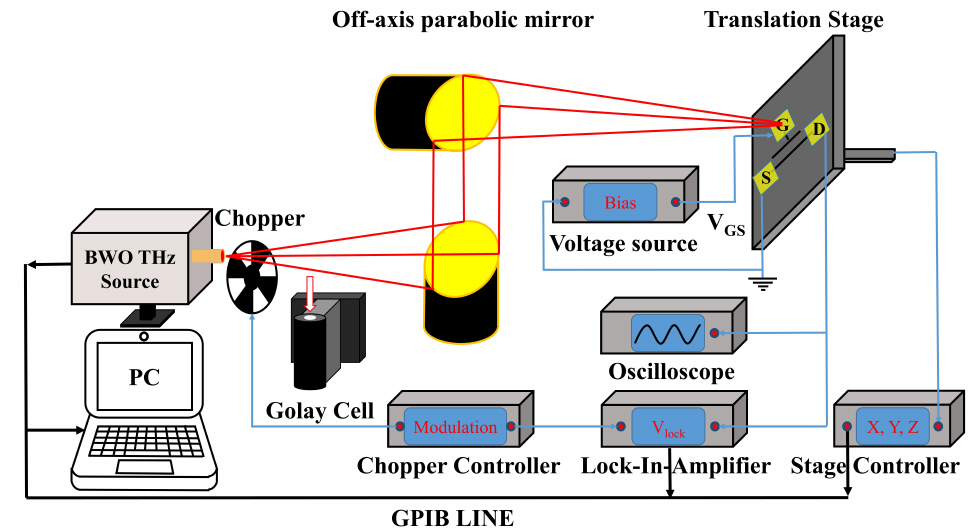
Figure 2. Experimental setup for the characterization of the THz